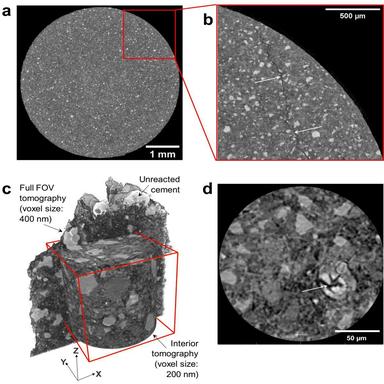
X-ray μCT images of P 0.45 cores. a, Example 2D image slice of a 4 mm diameter core acquired with FEI Heliscan microCT. b, Close-up of a microcrack in (a). c, 3D rendering of a 400 μm core imaged with Xradia 520 XRM. Dimensions in μm. d, Example 2D image slice from the interior tomographic volume in (c).